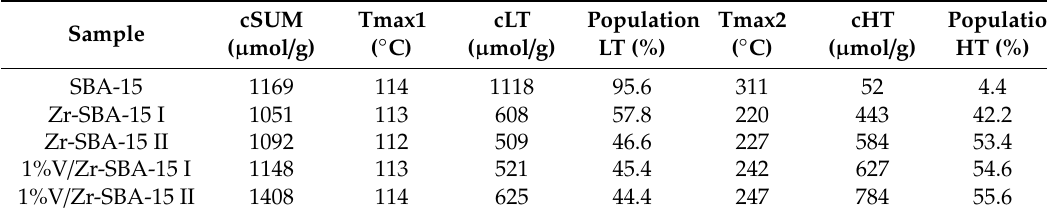
Table 4. Properties of acid sites determined by NH3-TPD. LT—low temperature sites; HT—high temperature sites.